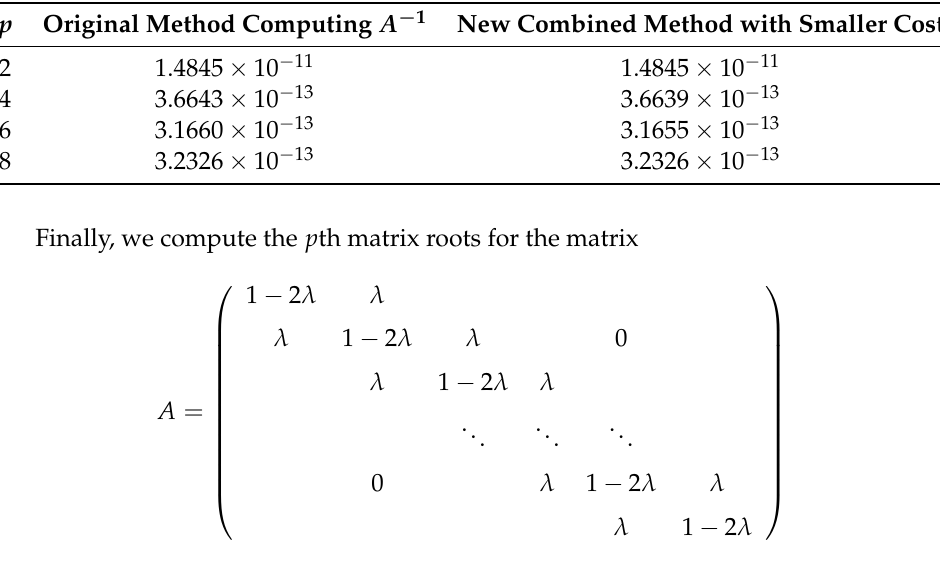
Table 1. Error for the approximation of A 1/ p , taking ( m , h , v , w ) = ( 100, 0.01, 20,000, − 10) and four